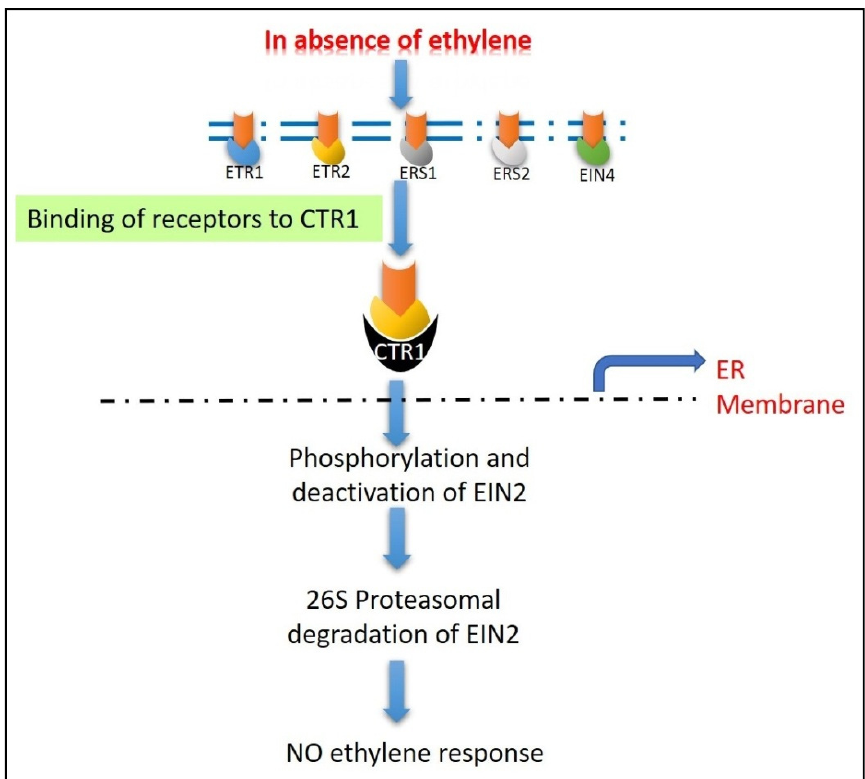
Figure 4. Signaling pathway involved in the absence of ethylene.